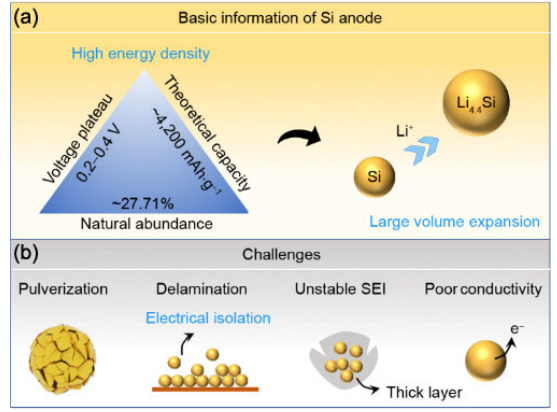
Figure 1 Overview of Si-based anodes for LIBs: (a) merits and (b) fundamental challenges. Reproduced with permission from Ref. [16], © Wiley-VCH GmbH